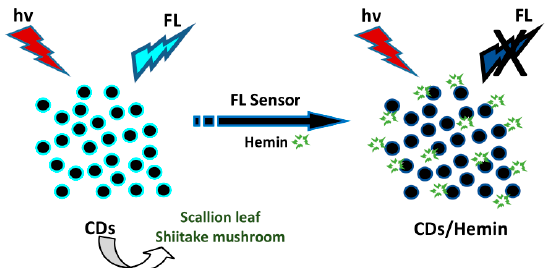
Figure 10. Schematic illustration of plant part-derived CDs for the sensing of hemin. The addition of hemin to CD solution exhibited an FL quenching